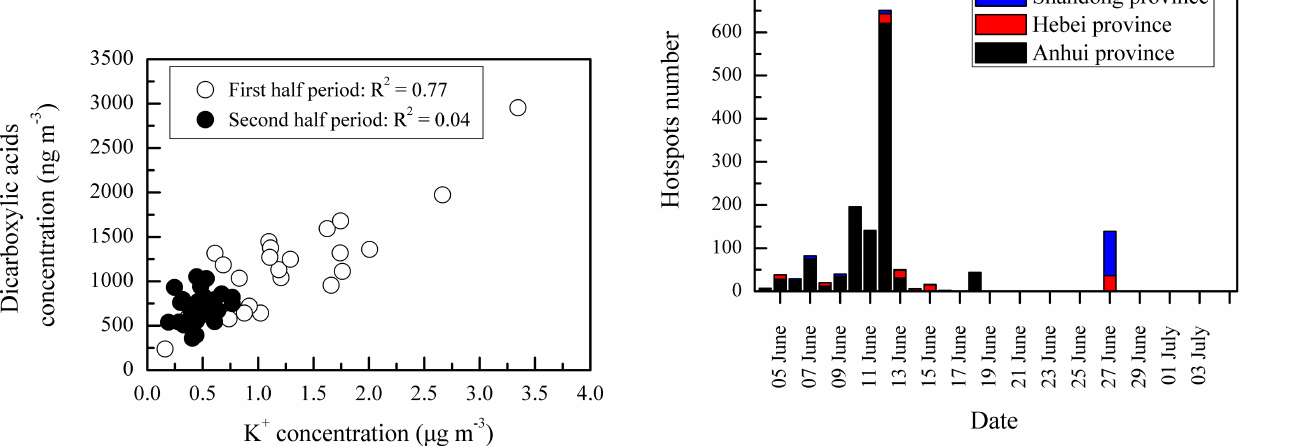
Figure 9. Scatter plot of concentration between K + and dicar- boxylic acids during the first and second halves of the campaign.